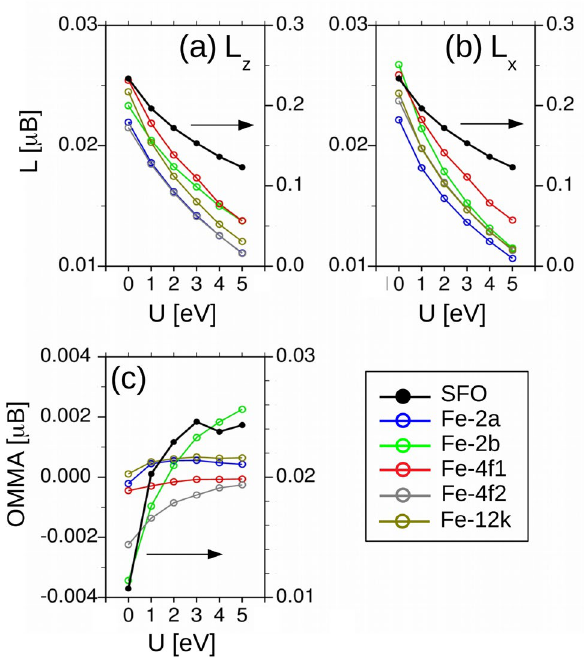
Figure 9. OMMs for the SFO unit cell (black line and right axis) and for each Fe ion (colored lines and left axis) for: ( a ) out-of-plane and, ( b ) in-plane spin quantization axis. In both plots the sign of the antiferromagnetically coupled 4 f 1 and 4 f 2 sublattices has been inverted for visualization purposes. ( c ) Orbital magnetic moment anisotropy, OMMA = L z − L x , for the SFO and each of the Fe sublattices. Here the signs of the 4 f 1 and 4 f 2 ions have not been inverted, so that their negative values correspond to an out-of-plane